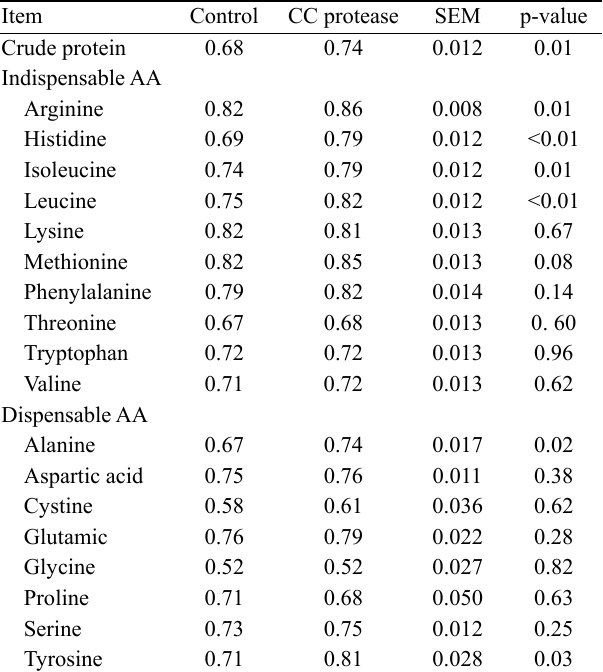
Table 5. Apparent ileal digestibility of crude protein and amino acids (AA) in basal diet or diet supplemented with 0.2